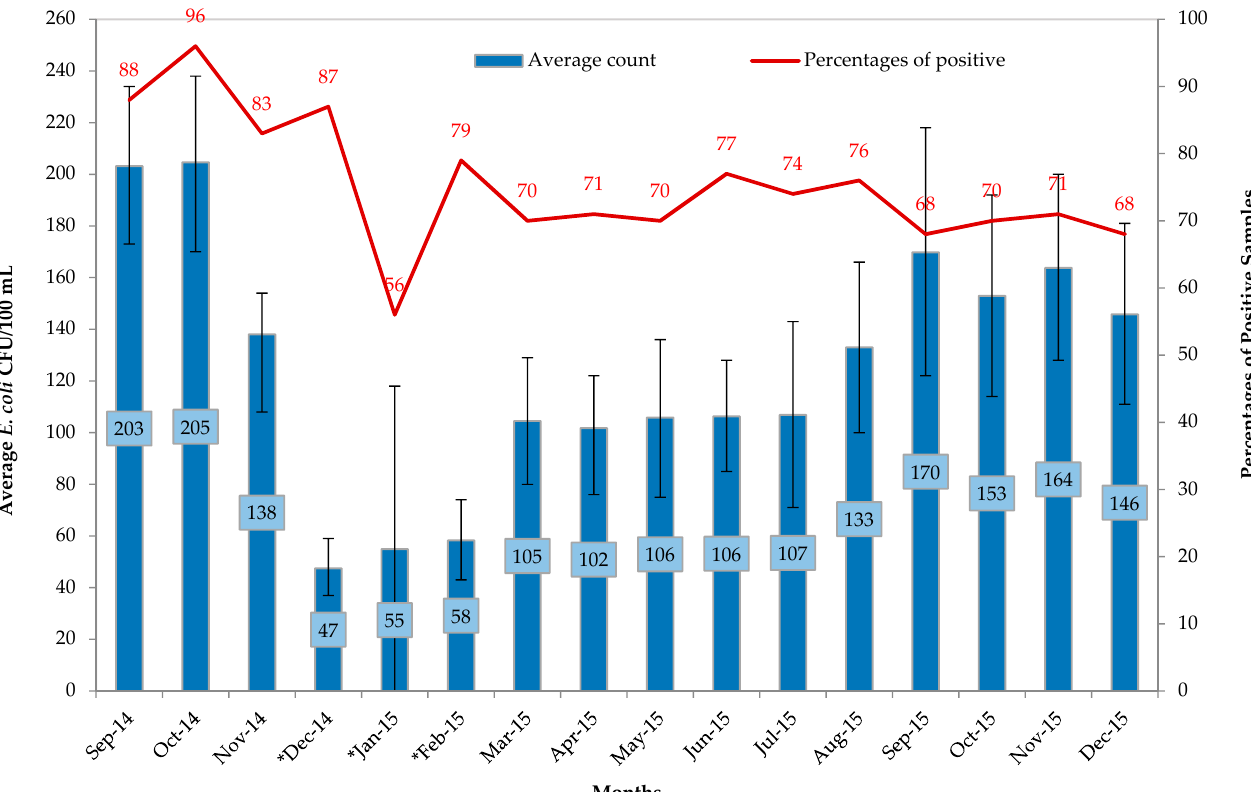
Figure 3. The proportion of E. coli positive samples and distribution of average E. coli counts in point-of-drinking water by different months from September 2014 to December 2015. Data collection between December 2014 and February 2015 was interrupted, and laboratory testing of samples was delayed due to political unrest in the country.